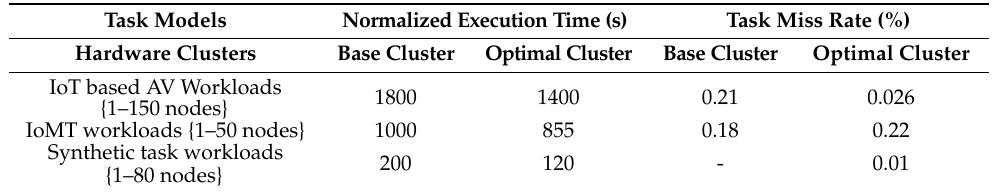
Table 7. Normalized Execution time obtained standard benchmark workloads Hardware configura- tion -1.